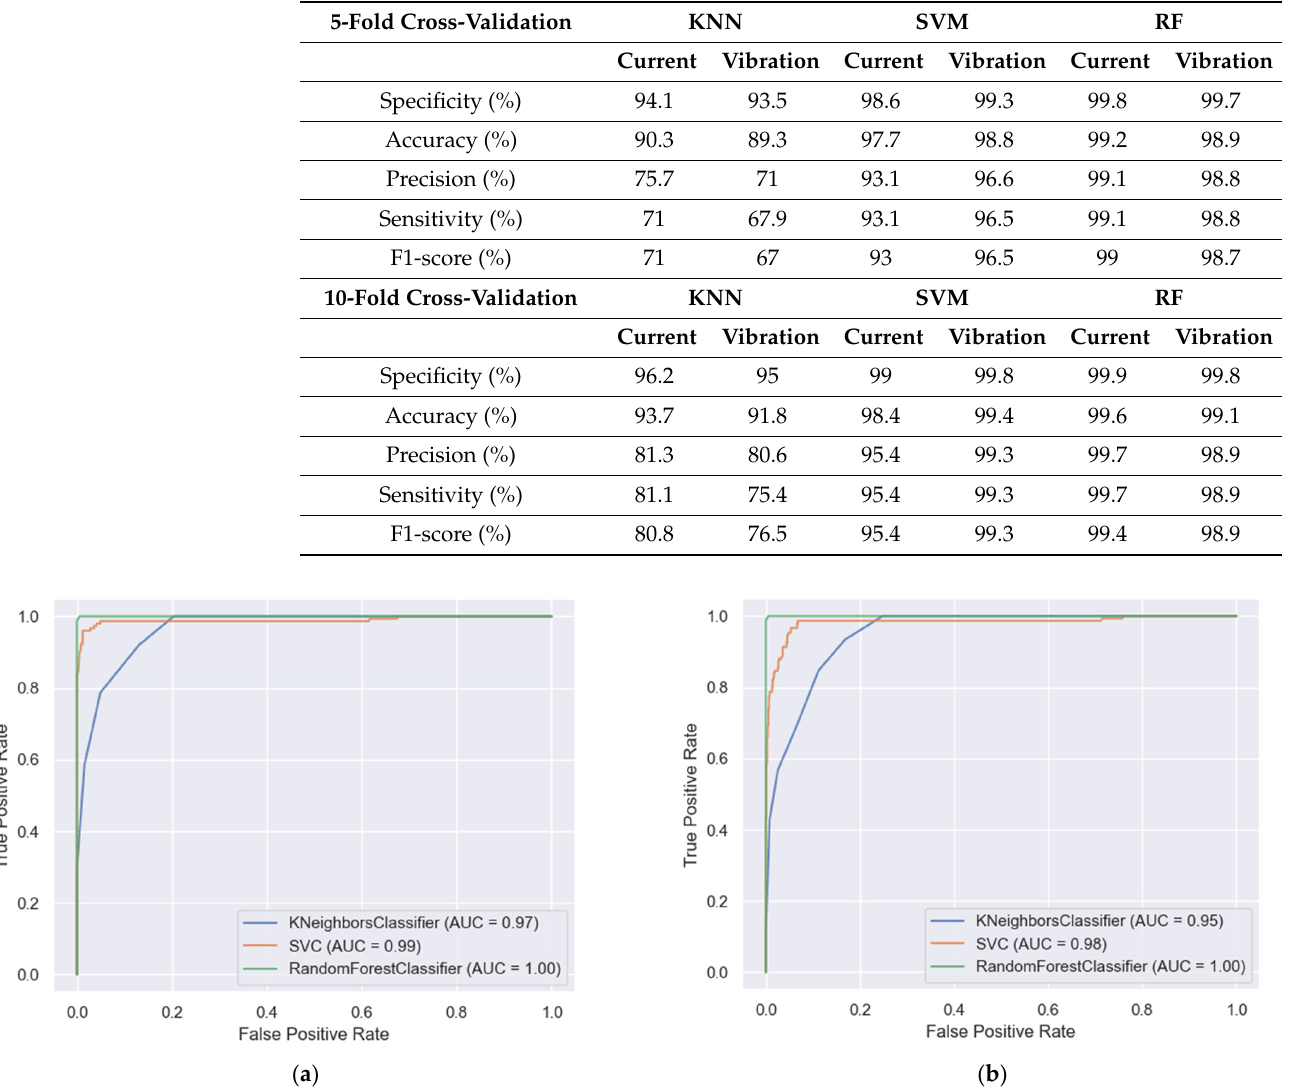
( b ) applying the vibration